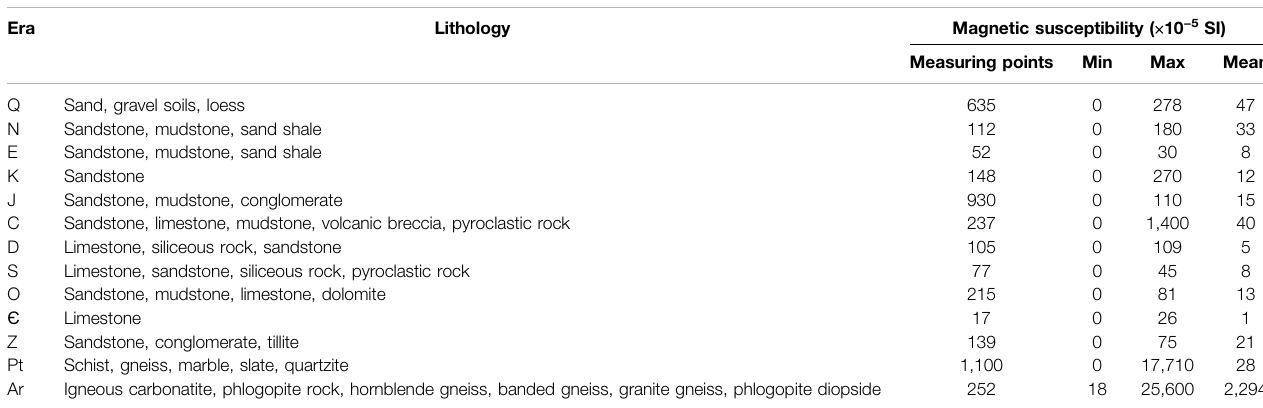
TABLE 1 | Measured magnetic susceptibility of exposure strata in the Eastern Tarim